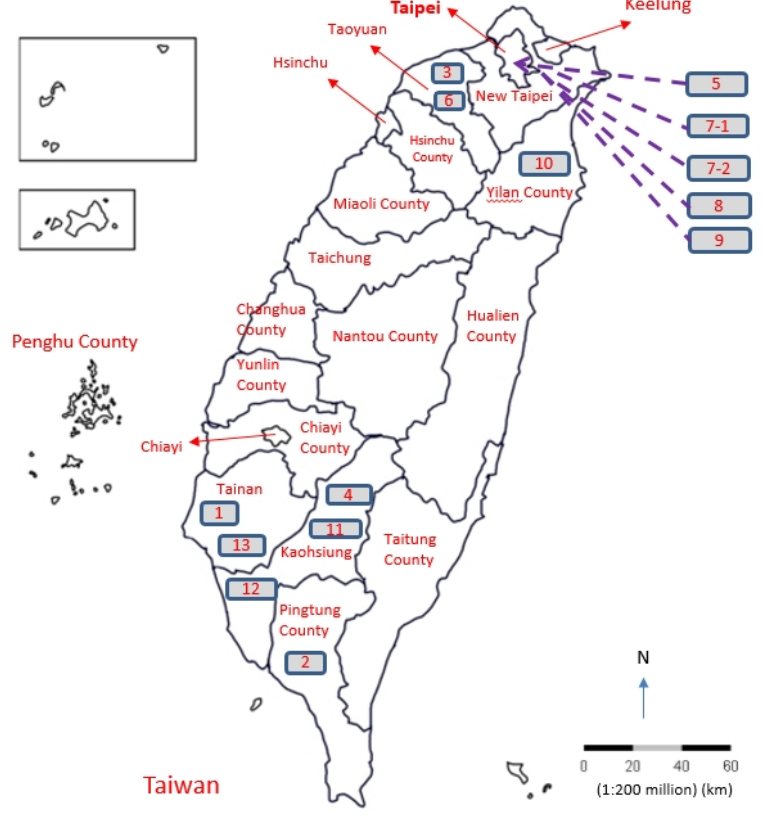
Figure 7. The locations of 14 dental clinics with installed ACD dental chairs in Taiwan. Table 5. Comparison of total colony counts before and after water quality improvement in dental clinics.